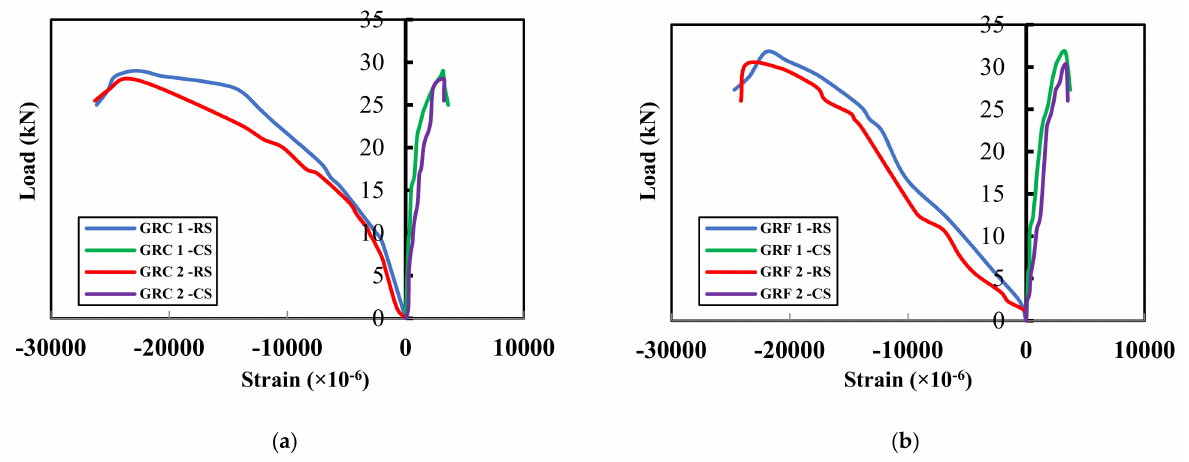
Figure 11. Load–strain behavior of ( a ) GRC and ( b ) GRF. RS—reinforcement strain; CS—concrete